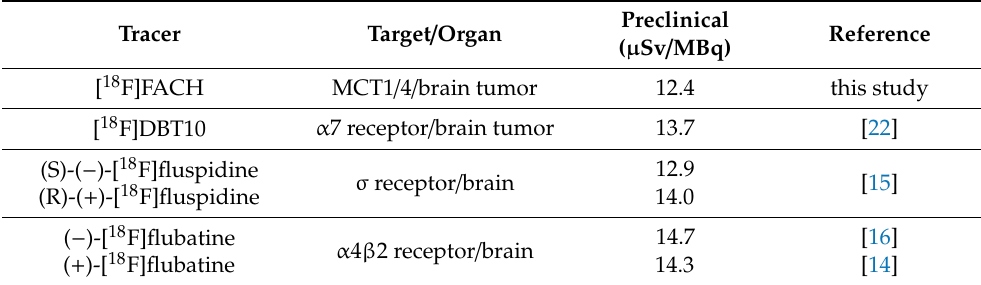
Table 2. Dosimetry results of di ff erent PET radiopharmaceuticals preclinically estimated using piglet biokinetic